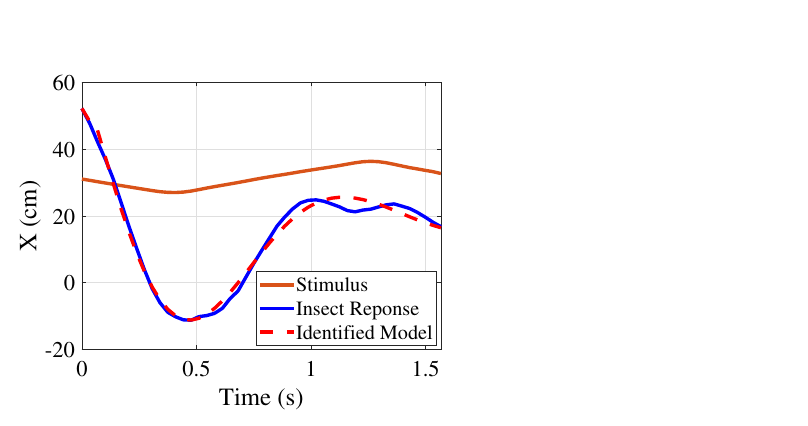
Figure 4. Example of time domain identifications used for trials ≤ 1.5 sec show tracking